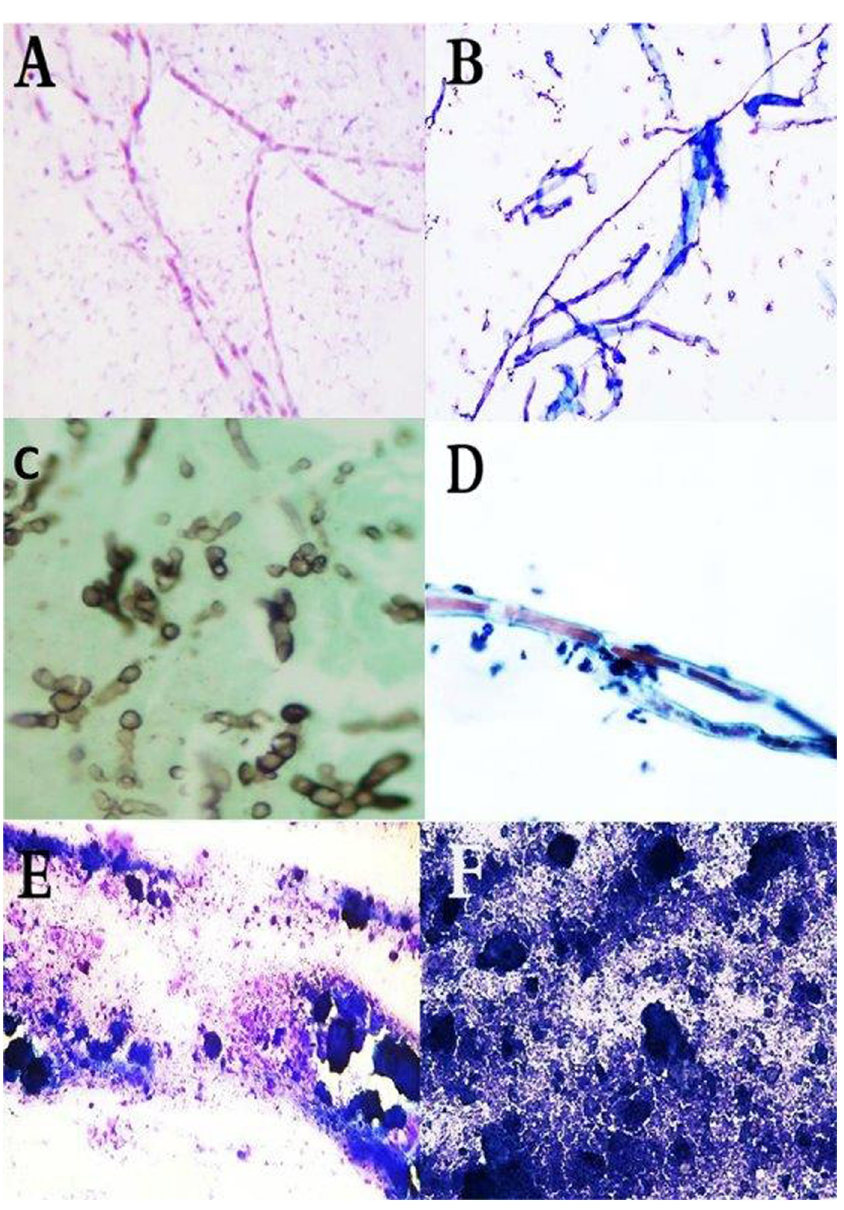
Fig 5. False positive identifications in cytology. Showing cytological smears of (A) M . mycetomatis hyphae stained with Giemsa stain, (B) Synthetic Fibers stained Wright-Giemsa stain. (Giemsa stain, X40). (C) Smear showing hyphae of M . mycetomatis . (D) Smear showing elongated structures of the Oedogoniales order. The chloroplasts form a chain interrupted by clear zones (X40). (E) Smear showing M . mycetomatis grains after being crushed on the smear. (F) smear with abundant calcific debris without intact cells taken from patient with tumoral calcinosis (Diff Quick, X10).